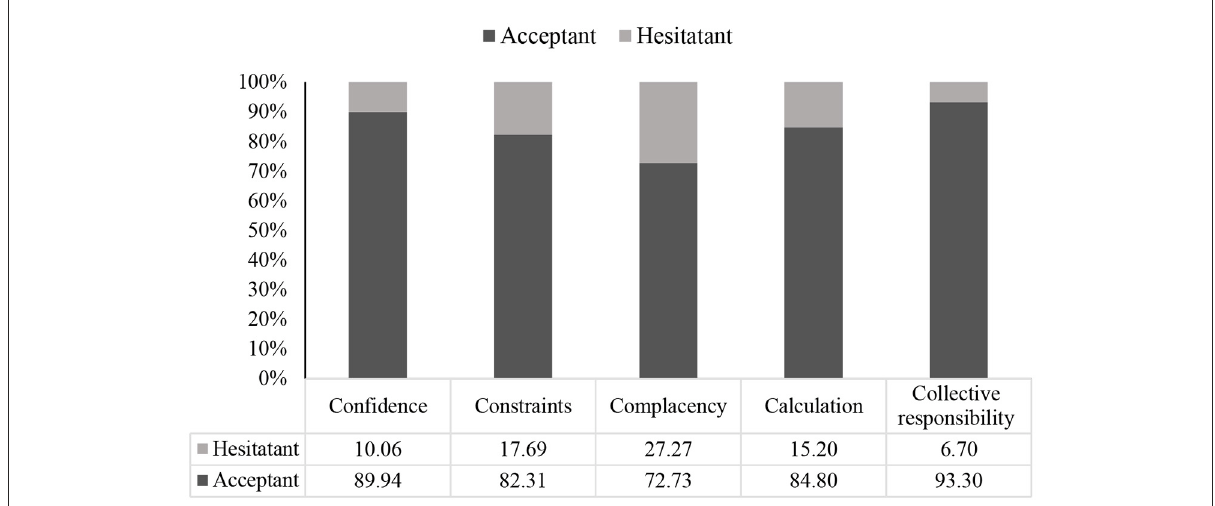
FIGURE2 Psychological antecedents for acceptance of the vaccine.